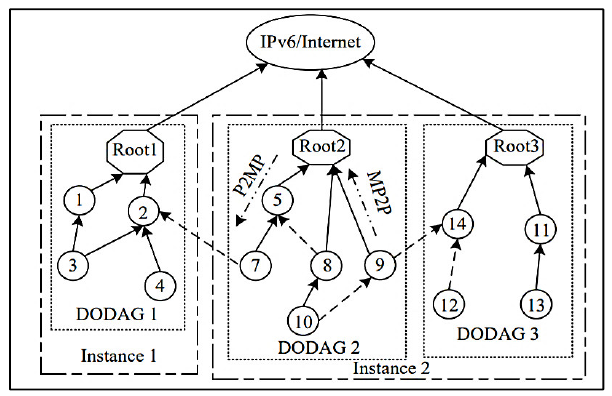
Figure 2. RPL DODAG Construction.